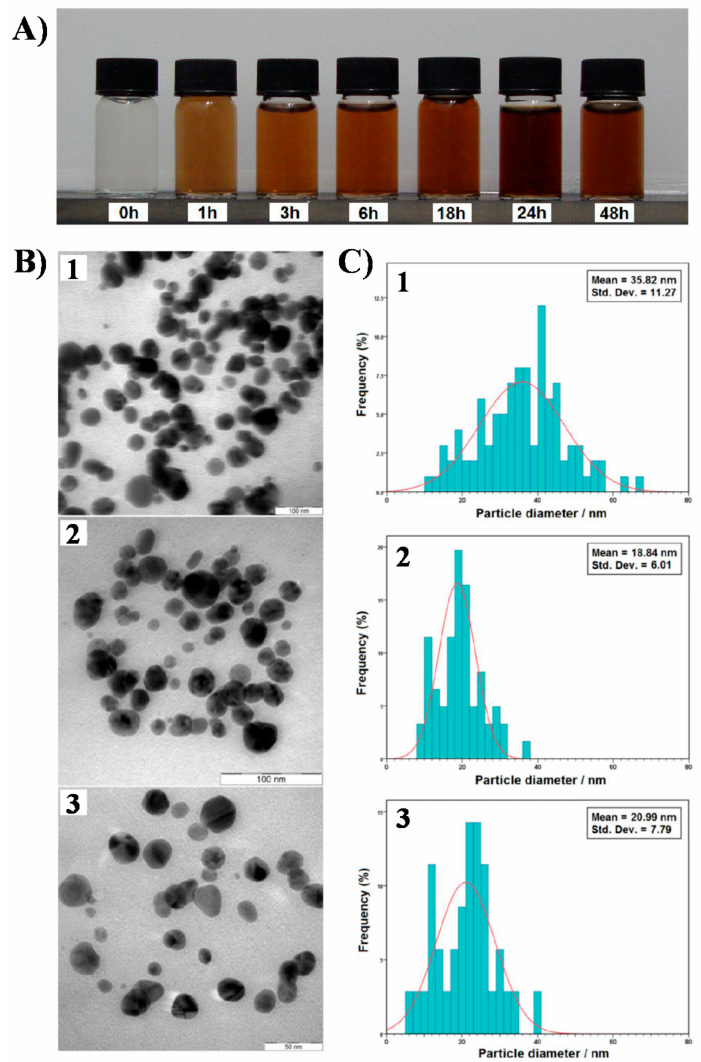
Figure 5. ( A ) Visual aspect of colloidal Ag NPs synthesized in 1% gelatin solution as the stabilizing agent at different UV-A light (6 W) irradiation times. ( B ) TEM images of Ag NPs at different UV irradiation times: (1) 6 h, (2) 24 h, and (3) 48 h. ( C ) Size distribution of Ag NPs obtained at different irradiation times: (1) 6 h, (2) 24 h, and (3) 48 h. Adapted from [89]. Published by MDPI under Creative Commons Attribution